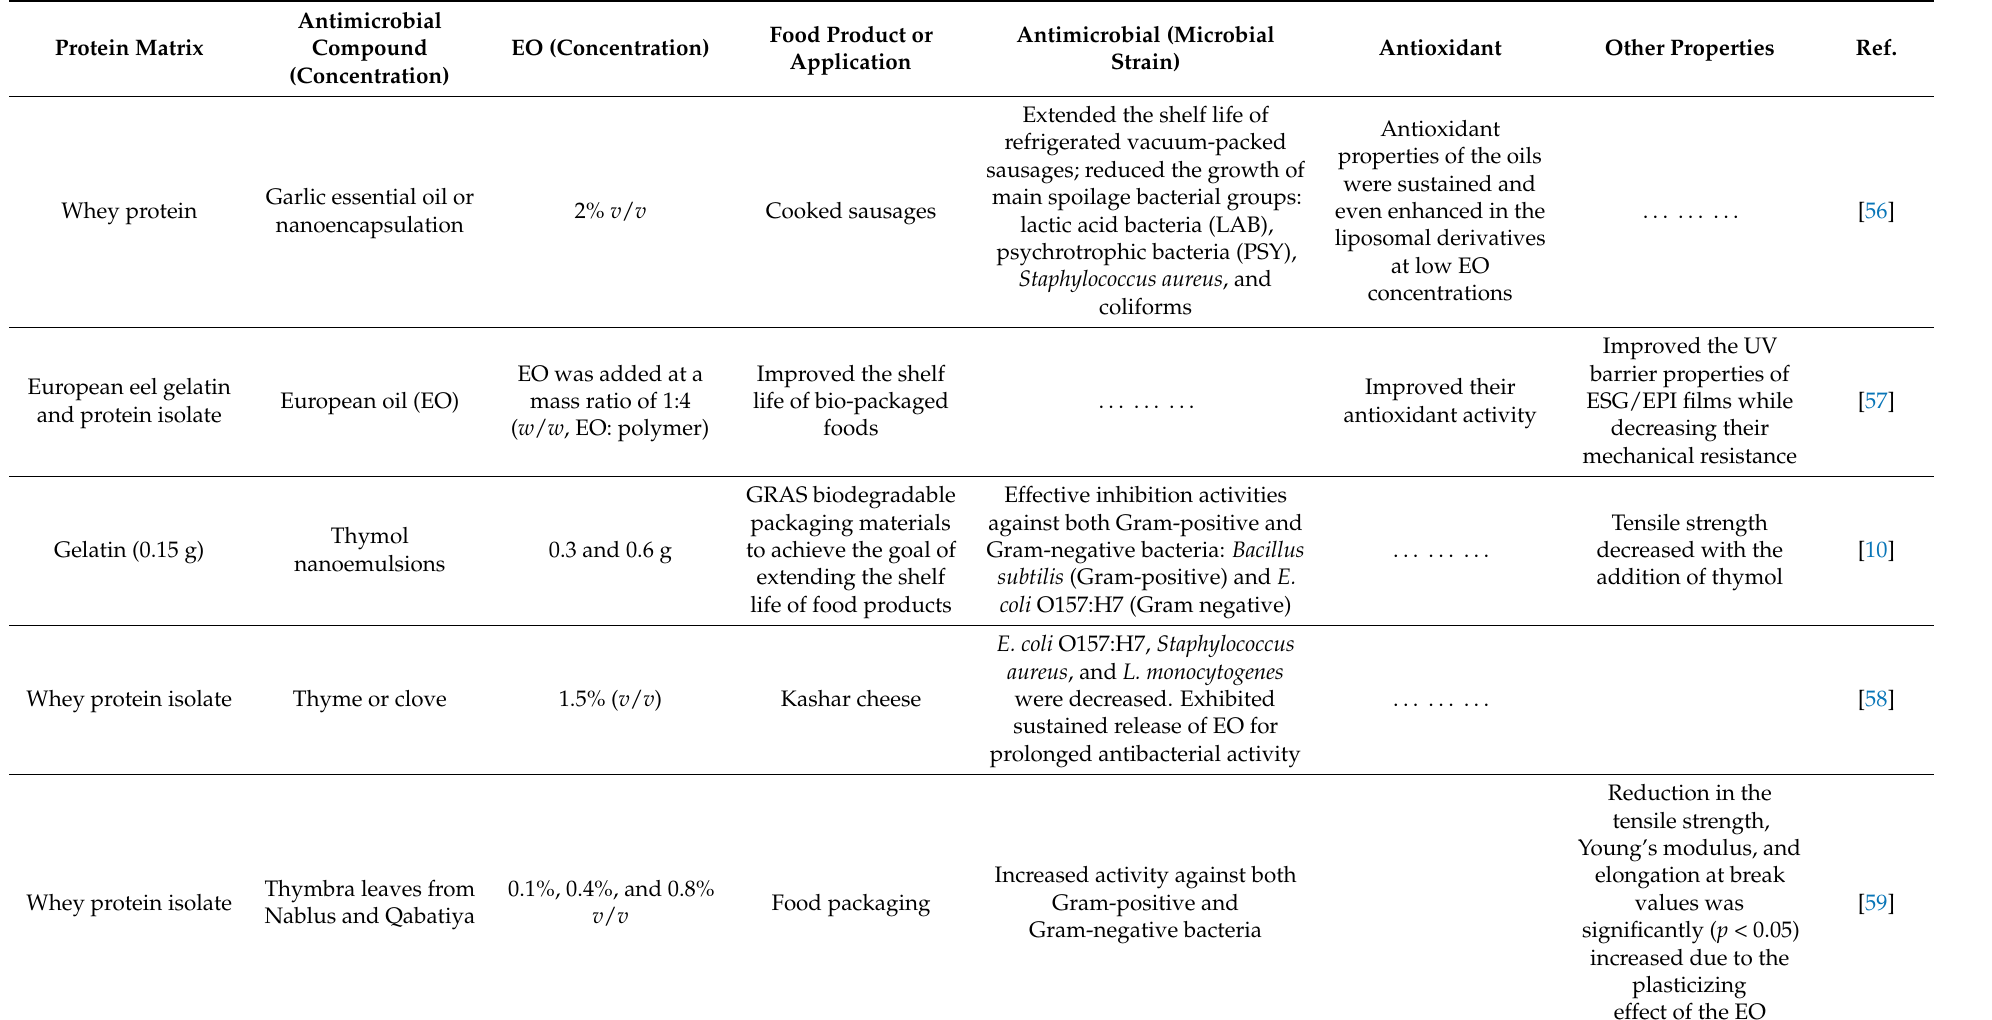
Table 1. Properties of protein/essential-oil-based